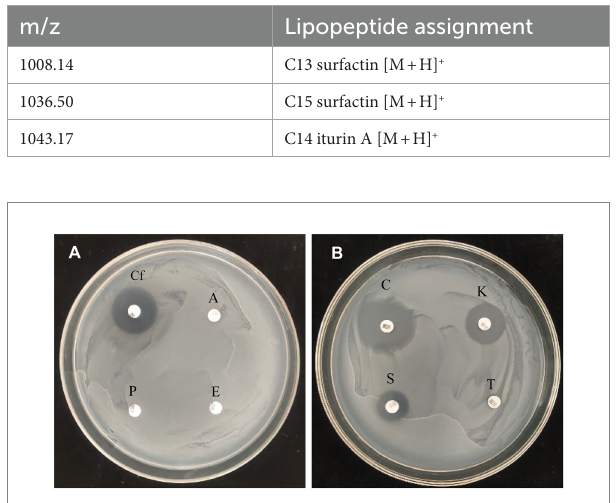
FIGURE 4 Antibiotic sensitivity test of P. megaterium KD7. (A) Cf , ciprofloxacin;